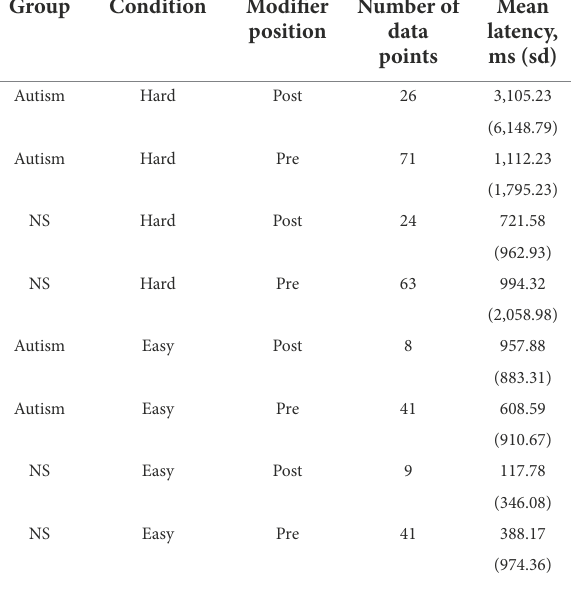
TABLE 3 Children’s mean latency to look at the target by group, condition, and modifier position (trials with no modifiers or with both pre- and postnominal modifiers were